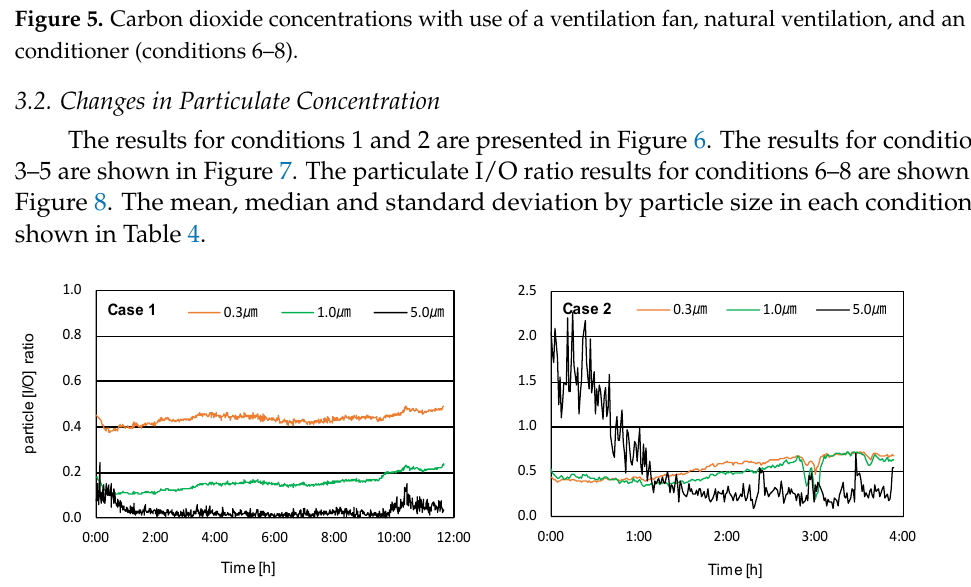
Figure 6. Particulate I/O ratio with and without ventilation fan (conditions 1 and 2).